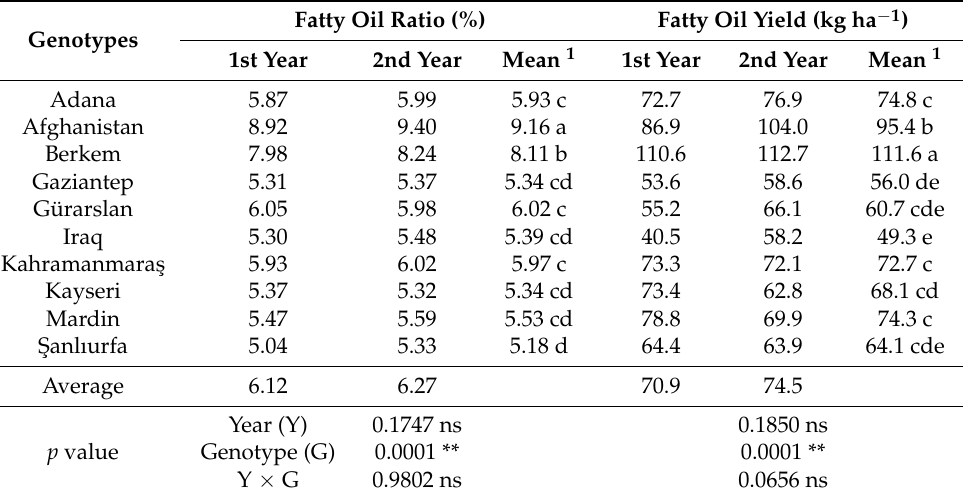
Table 8. Average values for fatty oil content and fatty oil yield of fenugreek